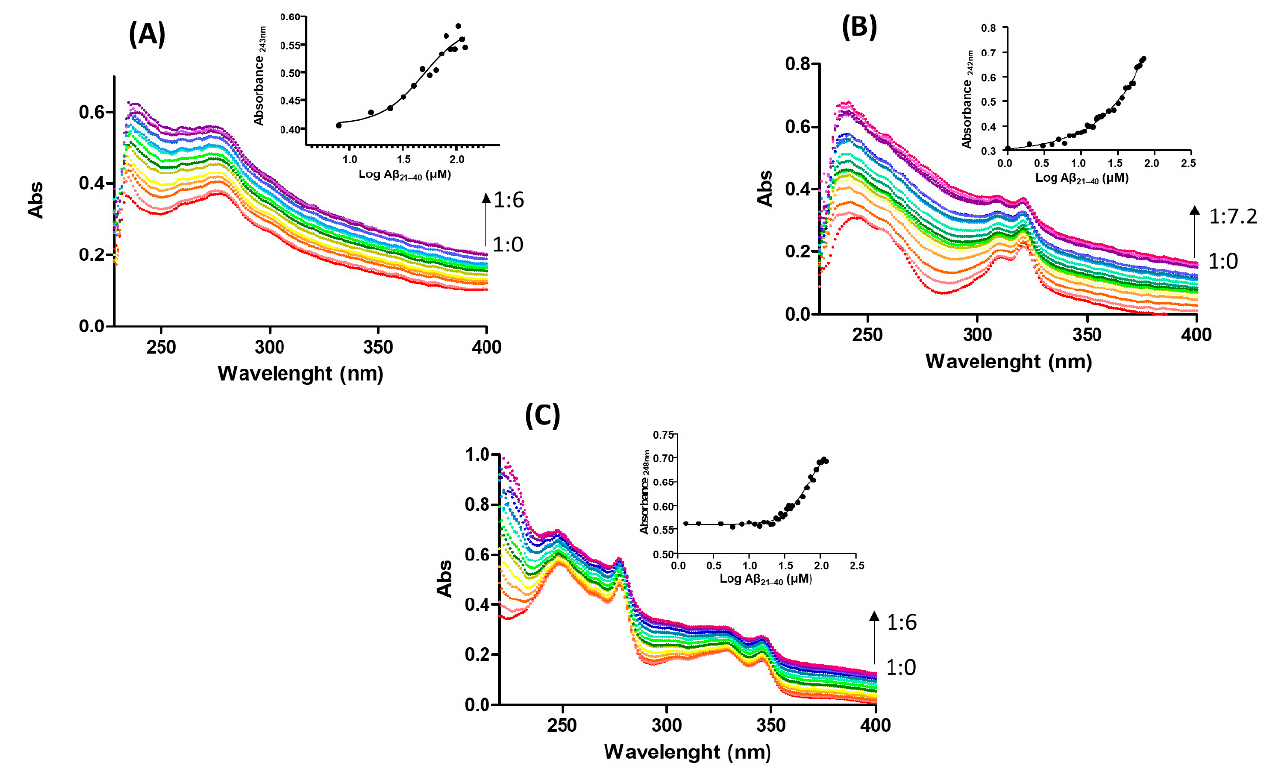
Figure 4. Absorption spectra of ( A ) Pt-phen, ( B ) Pt-bpy, ( C ) Pt-terpy upon the addition of increasing amount of A β 2–40 . Arrow indicates ratio variation between complex and peptide. As insets UV intensities at indicated wavelengths versus Log concentration of A β 21–40 are